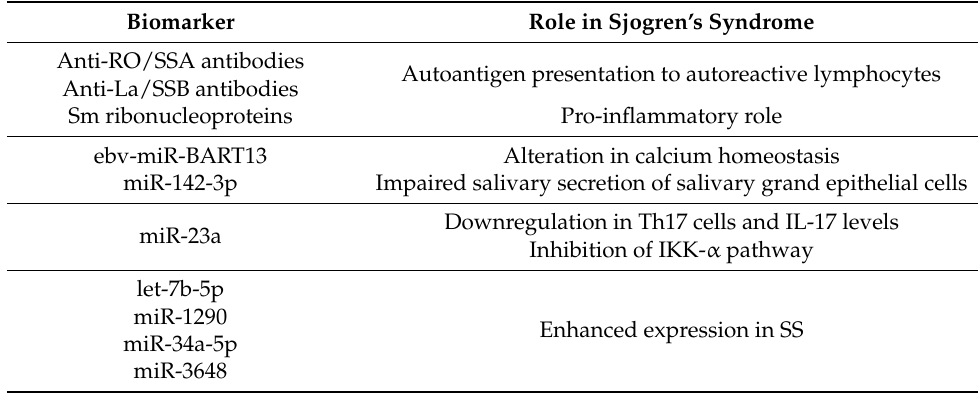
Table 1. Exosomal biomarkers in Sjogren’s disease and their respective